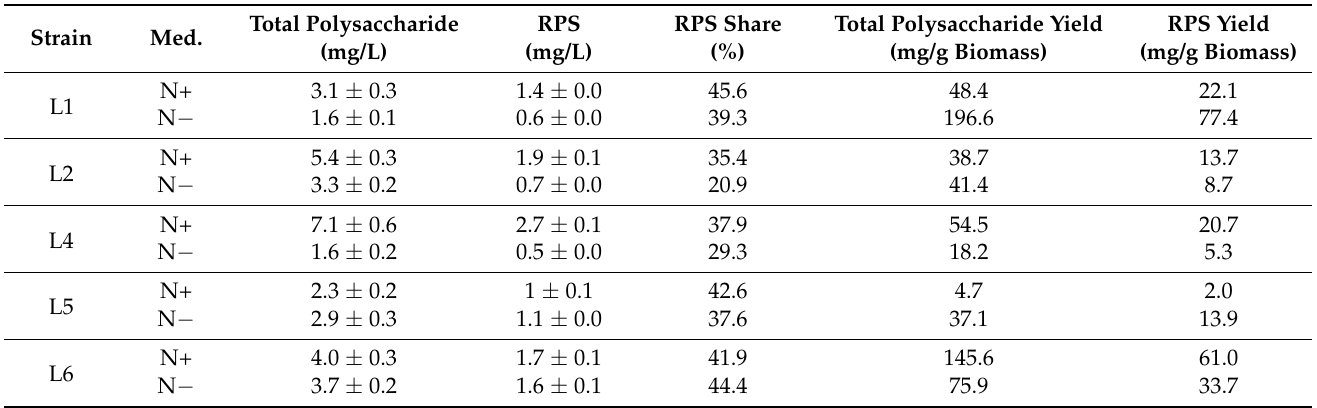
Table 3. Production of exopolysaccharides (RPSs) and total polysaccharides by isolated cyanobacterial strains. The polysaccharide content of strains in the 7th week of cultivation in BG11 N+ and BG11 N − media is presented. Strain Med.